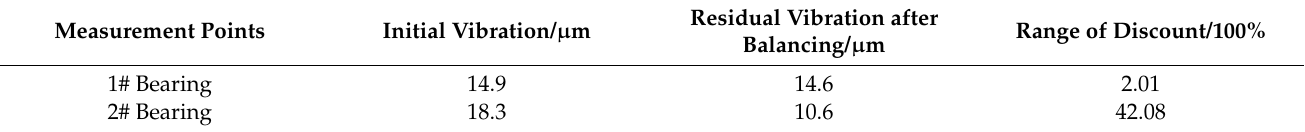
Table 4. Variation of bearing position amplitude.